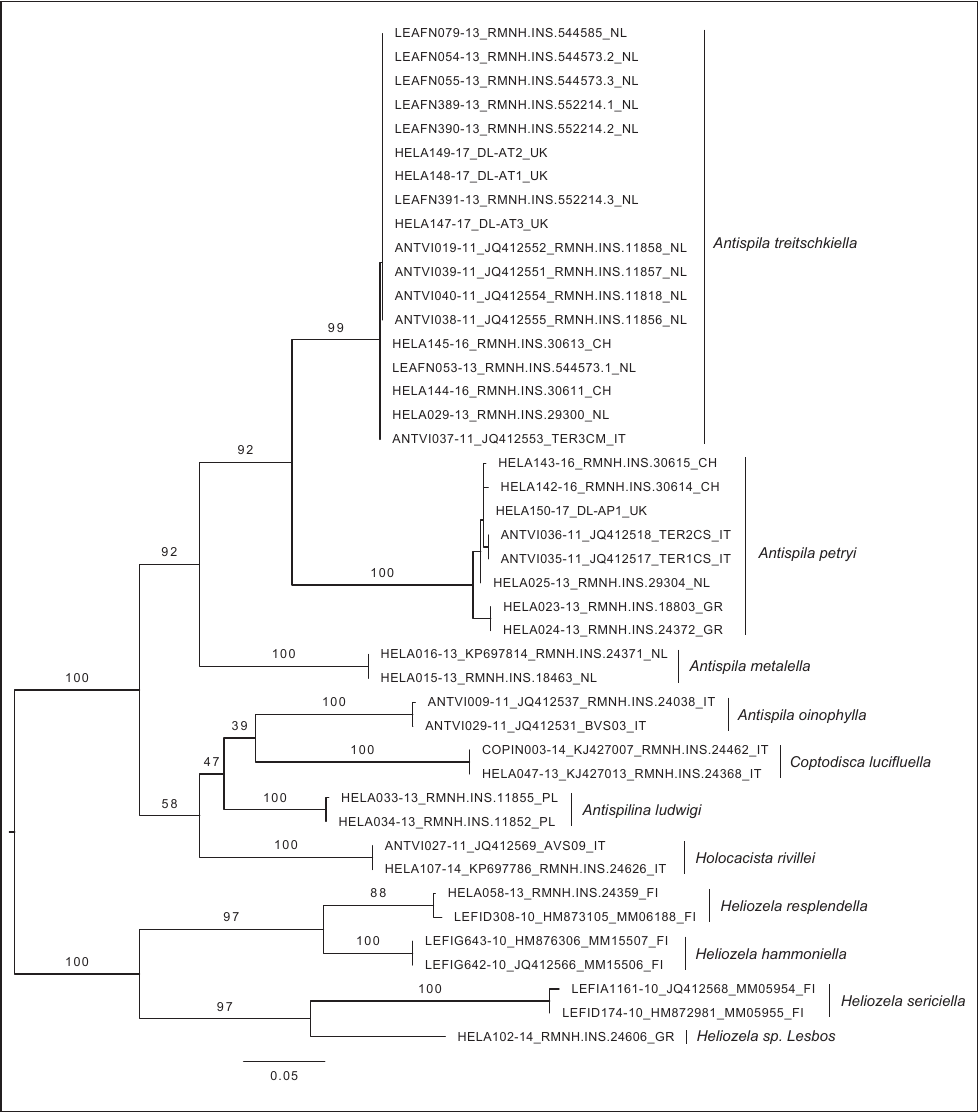
Figure 71. Maximum likelihood tree of COI barcodes of 43 European Heliozelidae belonging to 11 species. Bootstrap support values are omitted for intraspecific branching. See Table 1 and Suppl. material 1 for speci - men data, Suppl. material 2: Fig. S2 provides a Neighbor Joining